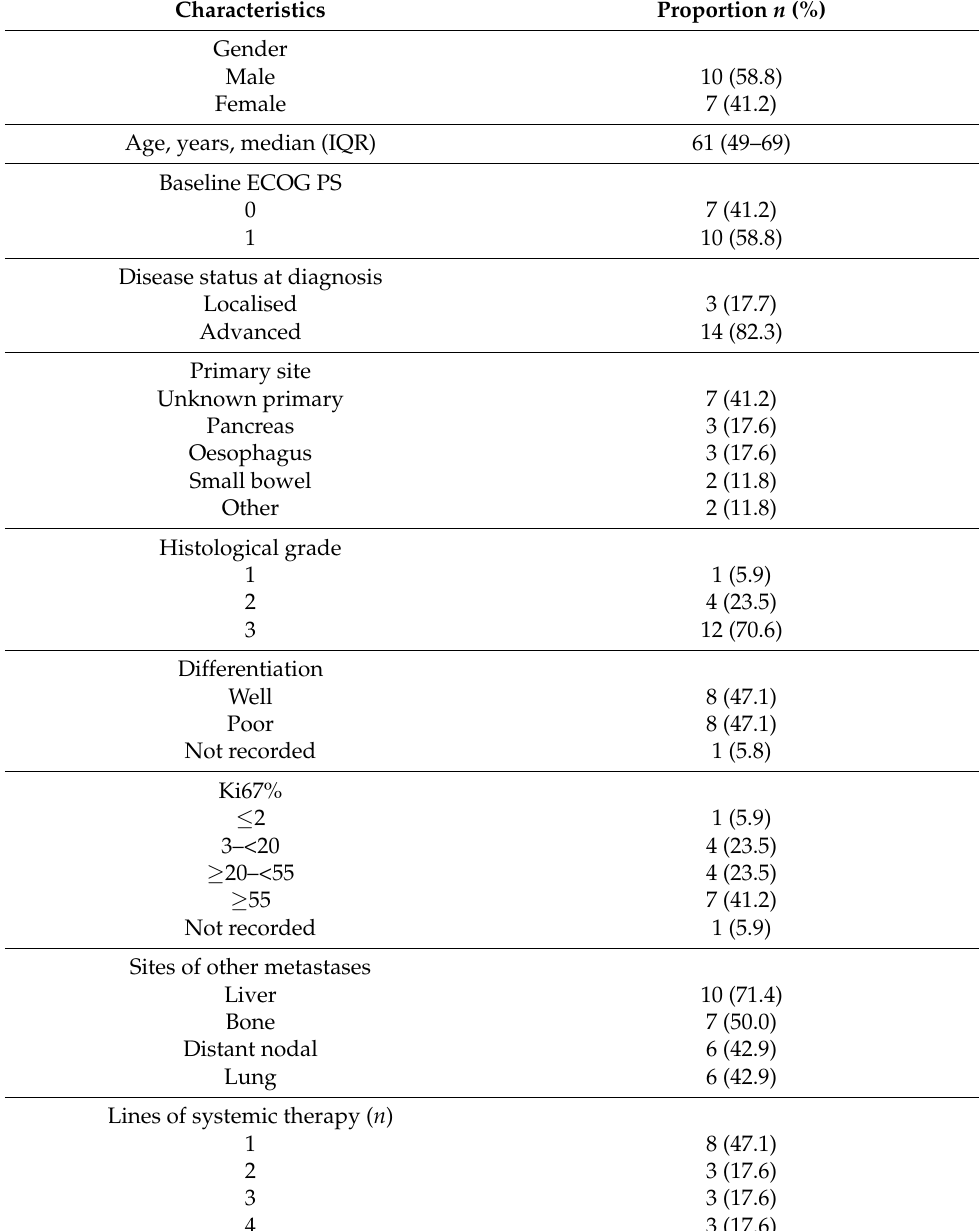
Table 2. Baseline characteristics of patients with extra-pulmonary neuroendocrine neoplasms and brain metastases ( n =